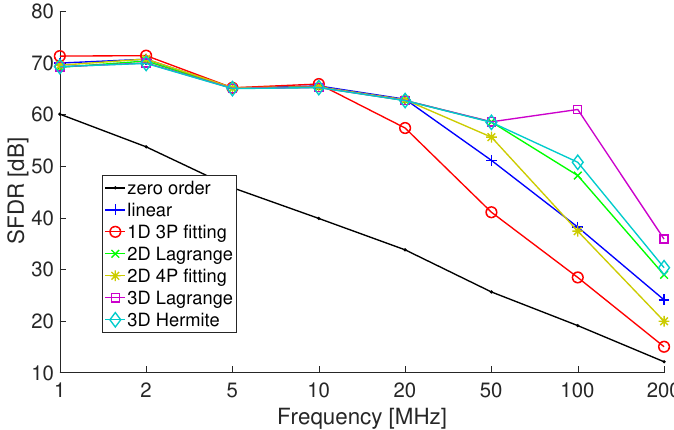
Figure 4. Spurious-free dynamic range (SFDR) offered by the resampling approaches based on the use of approximating